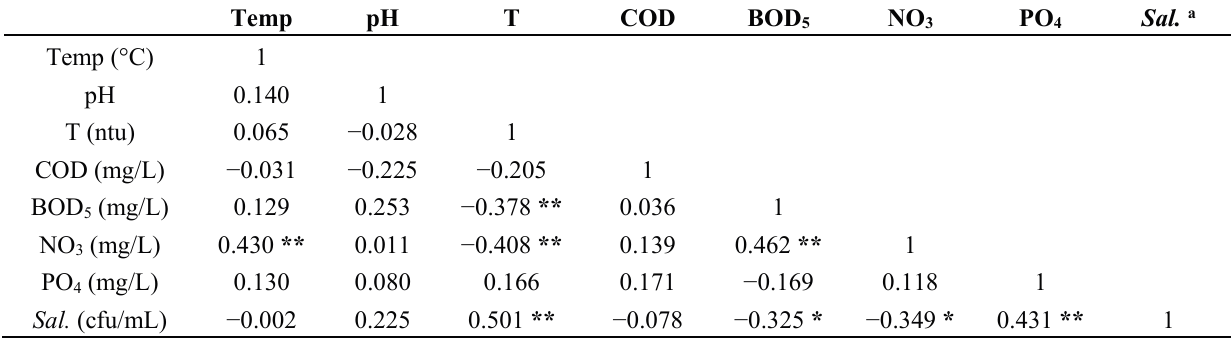
Table 4. Correlation matrices of the physicochemical parameters at the